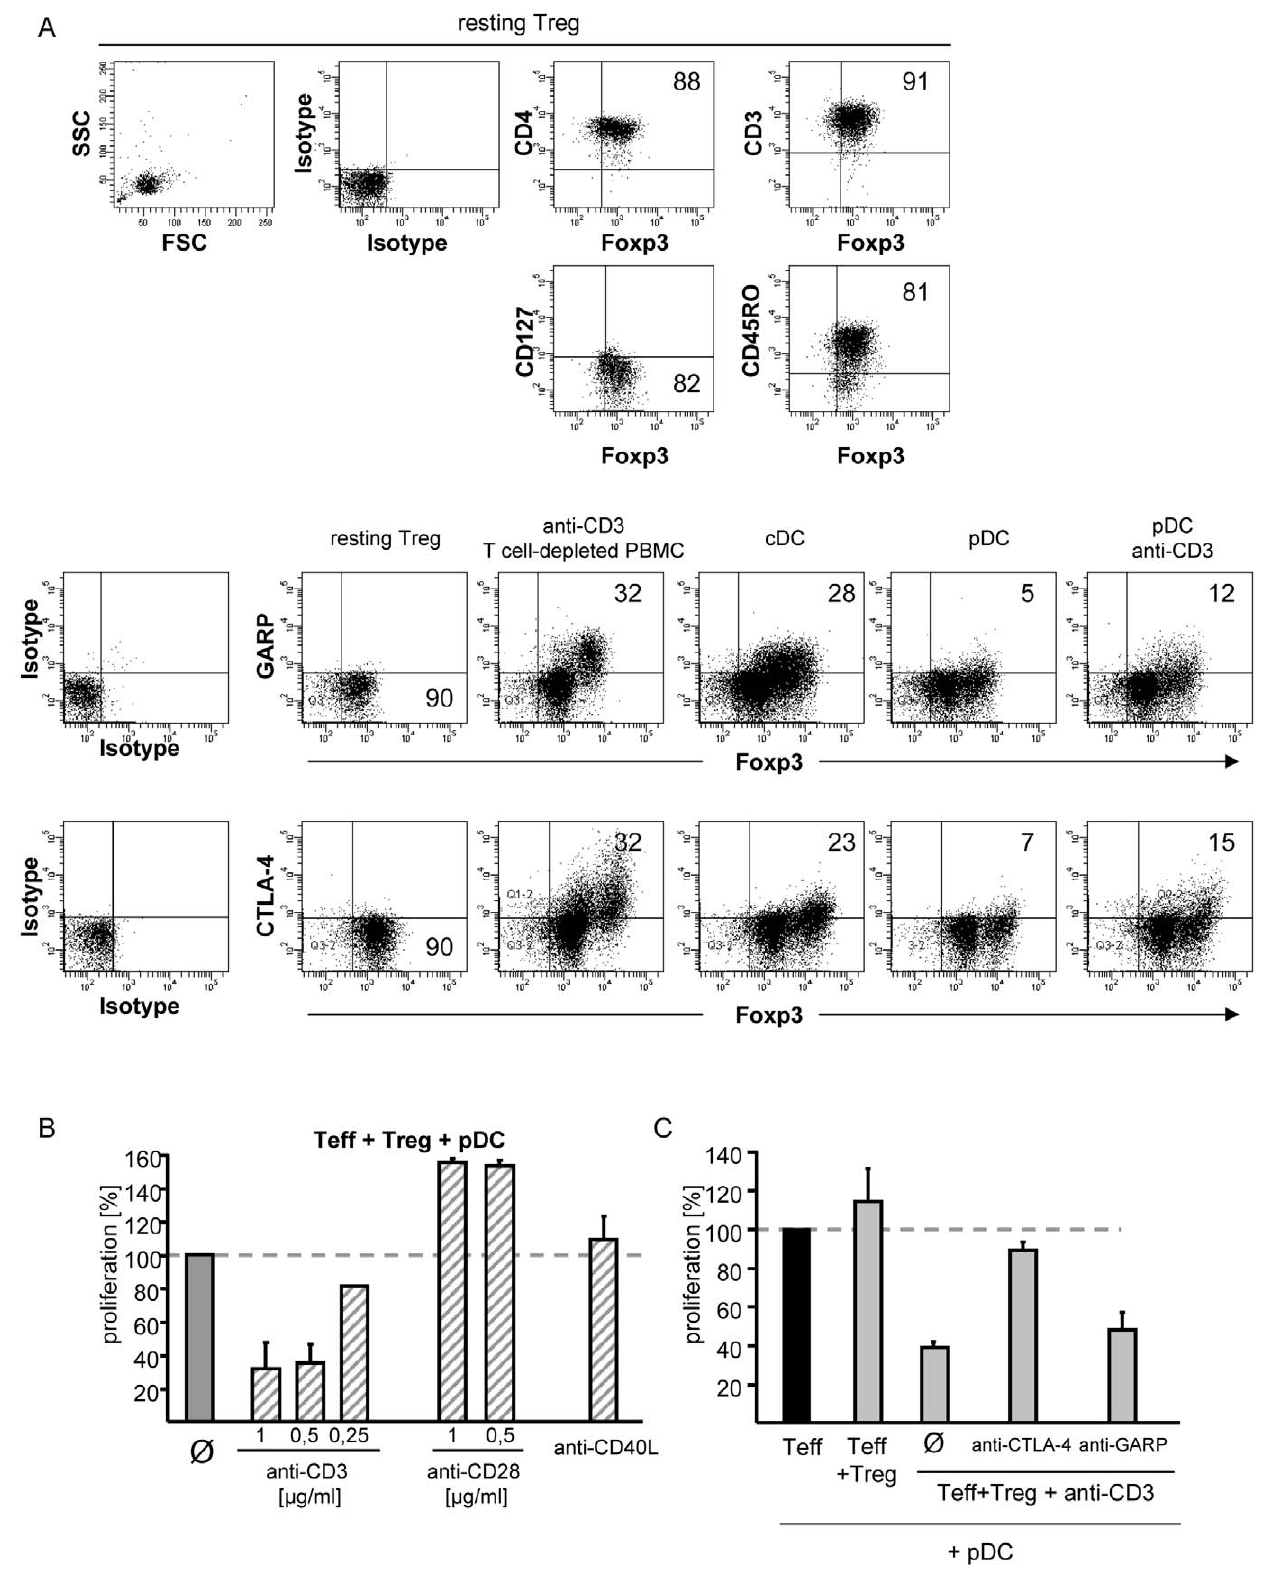
Figure 5. Plasmacytoid dendritic cells are unable to activate the suppressive function in human regulatory T cells. A: Surface expression of CTLA-4 and GARP on resting and differently stimulated Treg. Upper panels: flow cytometric characterization of resting CD25 + Tregs stained for indicated markers. Lower panels: Treg were stimulated with anti-CD3 mAb (5 m g/ml) plus T cell-depleted PBMC or allogeneic cDC (1:5), pDC (1:5) or pDC plus 5 m g/ml anti-CD3 mAb for 48 h. Flow cytometric analysis of CTLA-4 (extracellular expression), GARP and Foxp3 is shown.